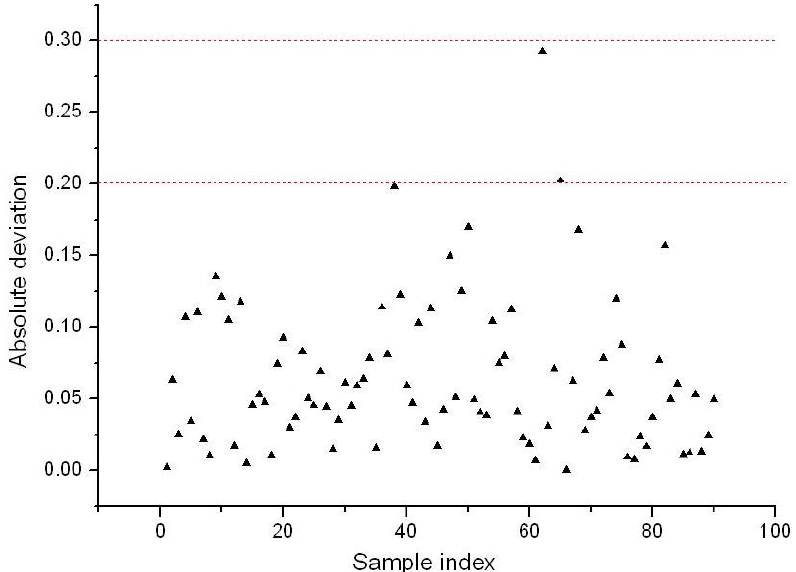
Figure 8. The absolute deviation value of prediction results of